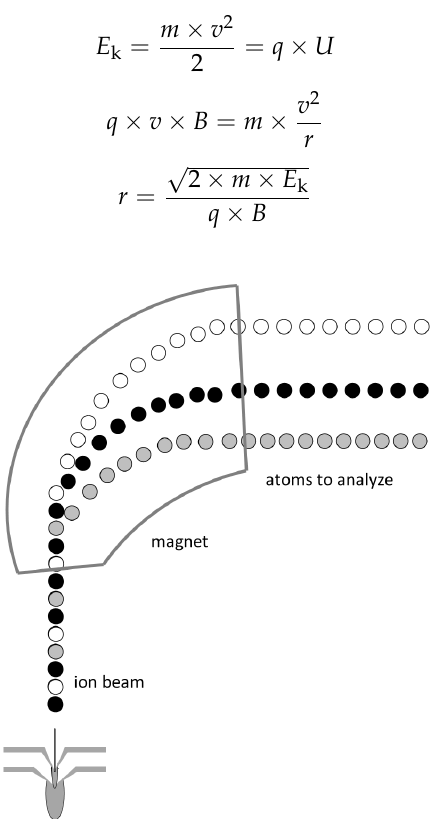
Figure 8. Magnetic analyzer (adapted from [70]).